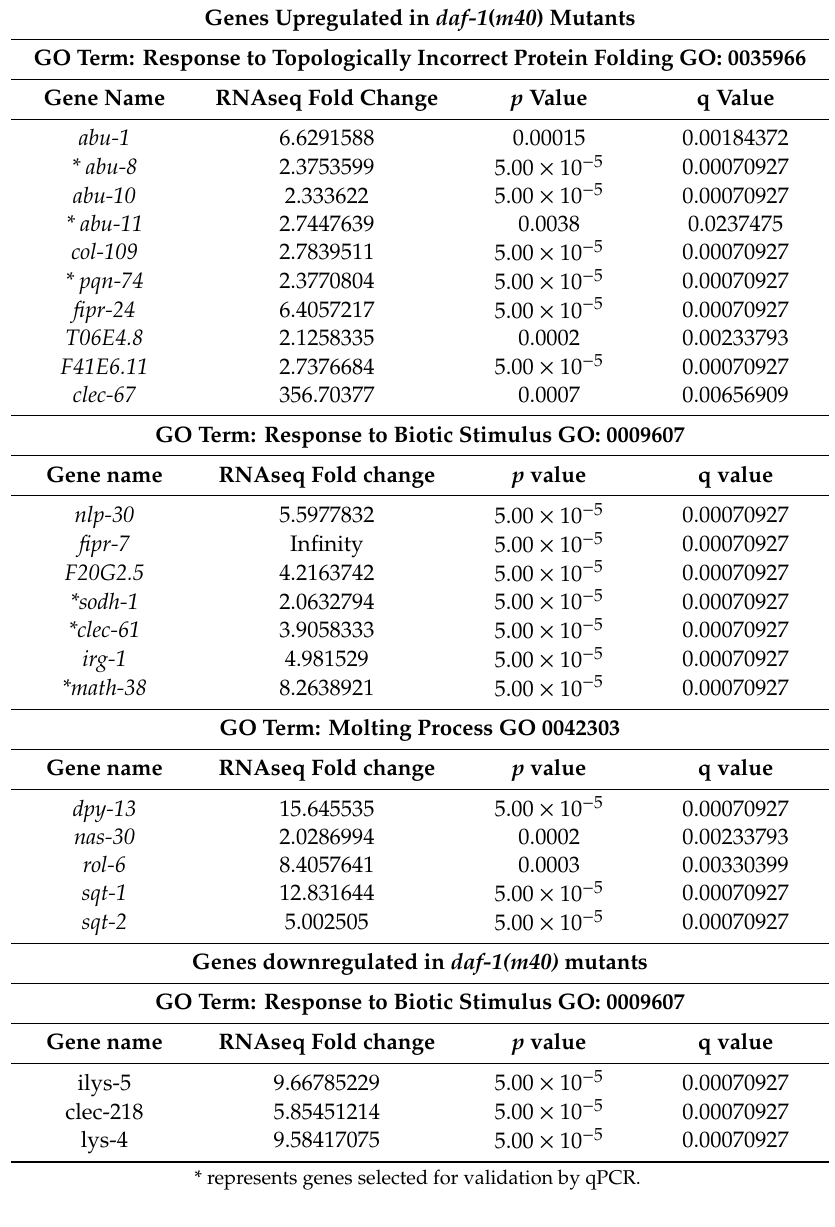
Table 2. Genes in each GO term associated with biological